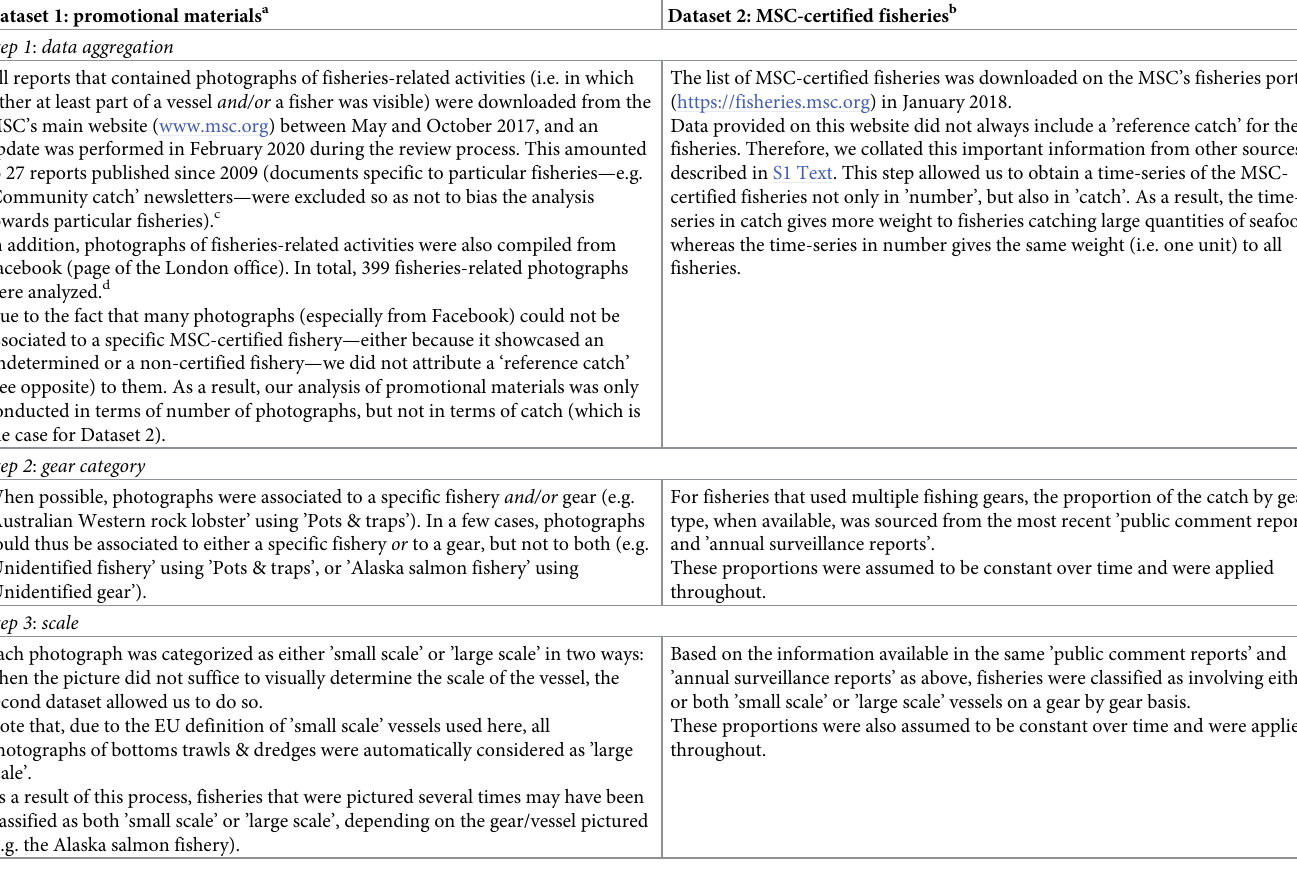
Table 3. Creation of the two datasets used to compare the fisheries the MSC features in its promotional materials and MSC-certified